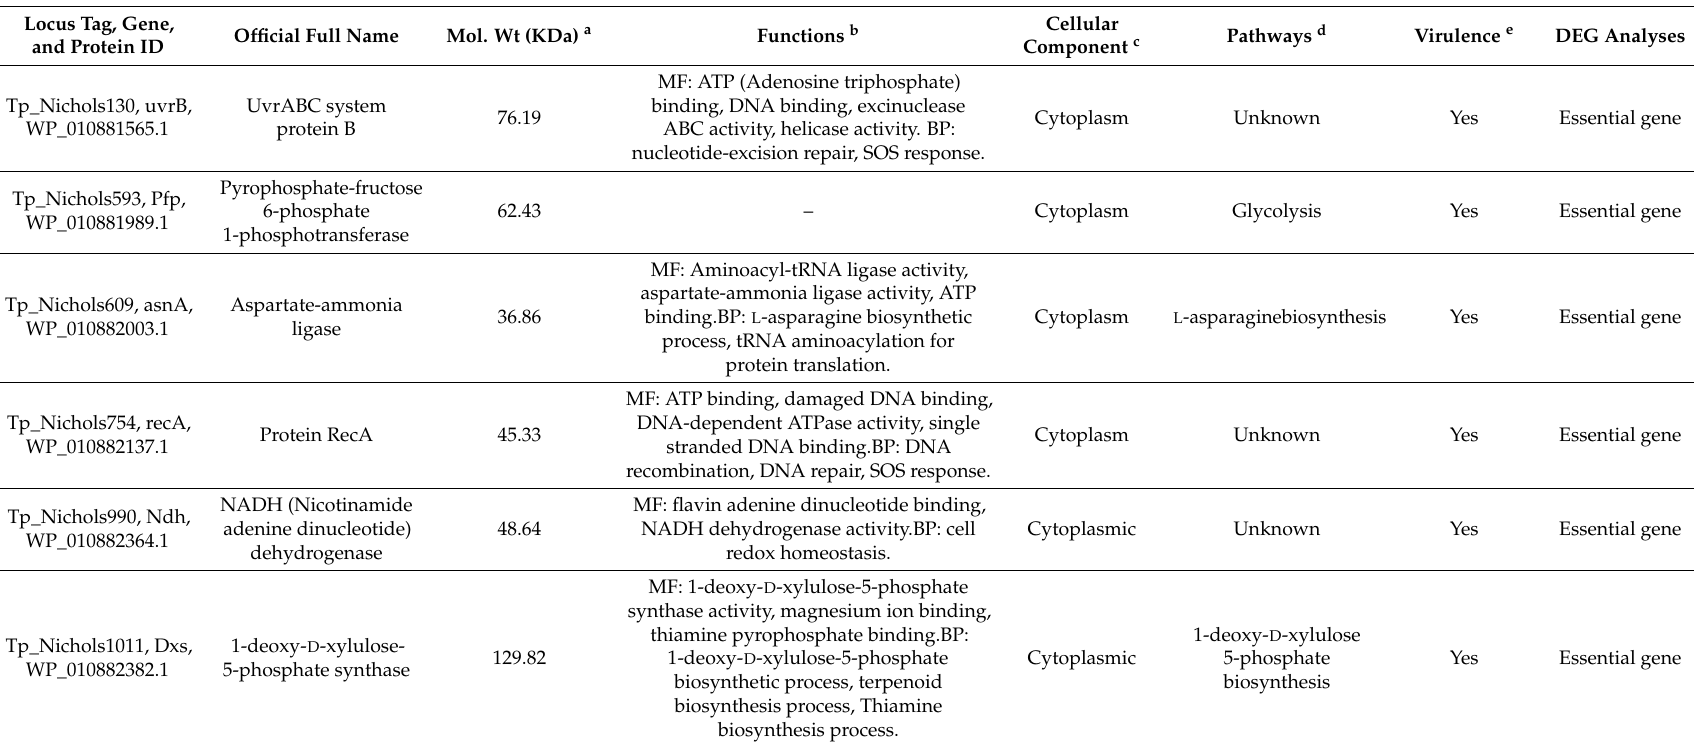
Table 4. Drug target prioritization parameters and functional annotation of the six non-homologous putative targets. Locus Tag, Gene, and Protein